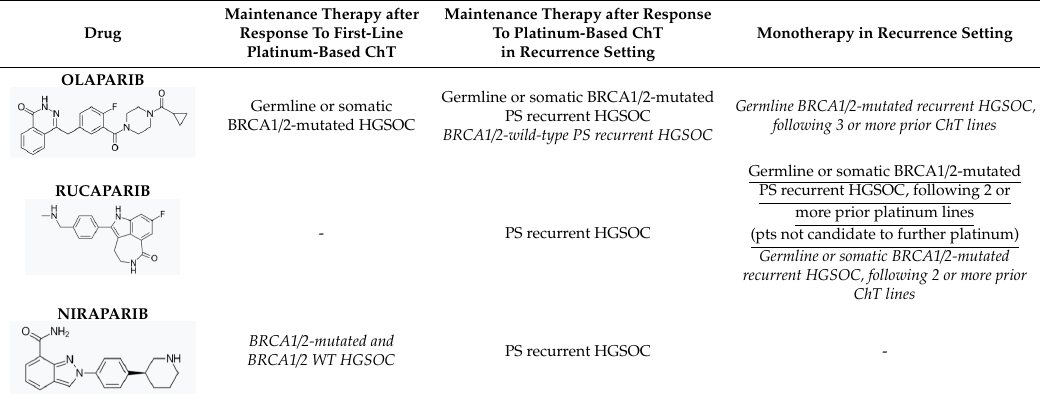
Table 1. FDA and EMA approvals for Poly (ADP-ribose) Polymerase (PARP) inhibitor (PARPis) Monotherapy in ovarian cancer